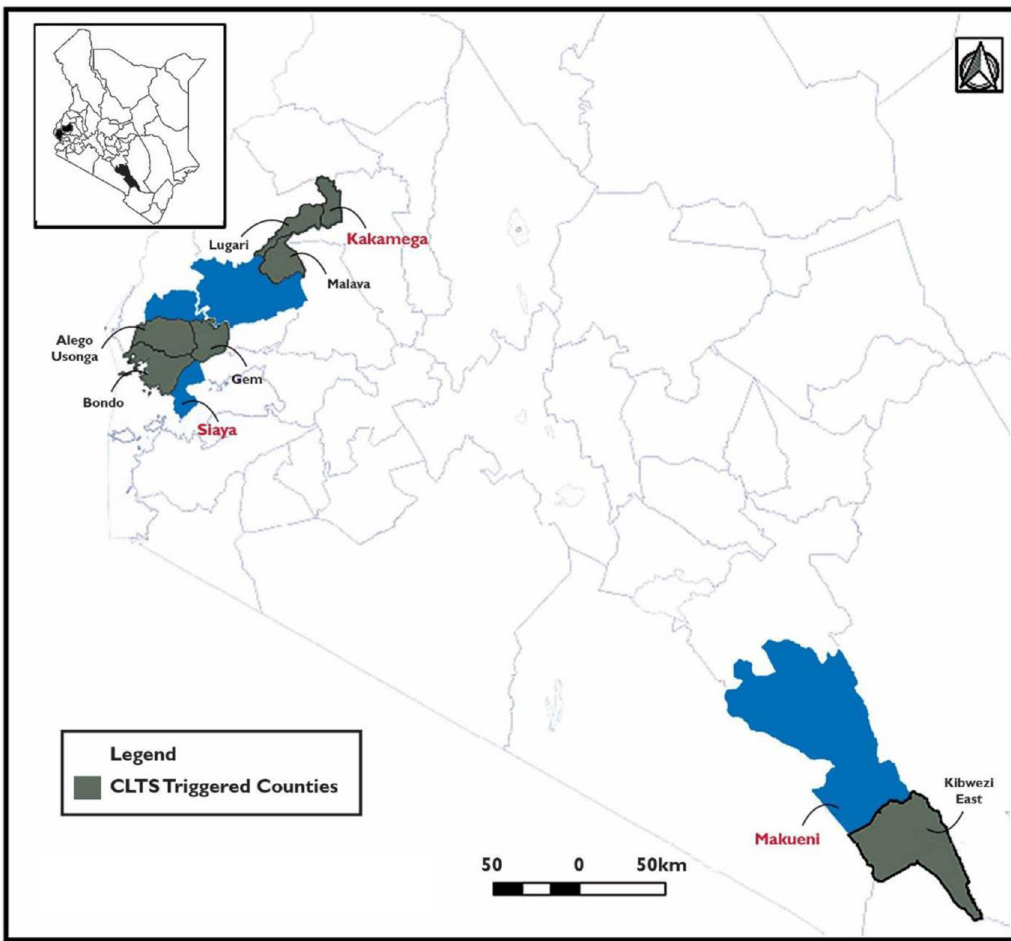
Fig 2. Map of study